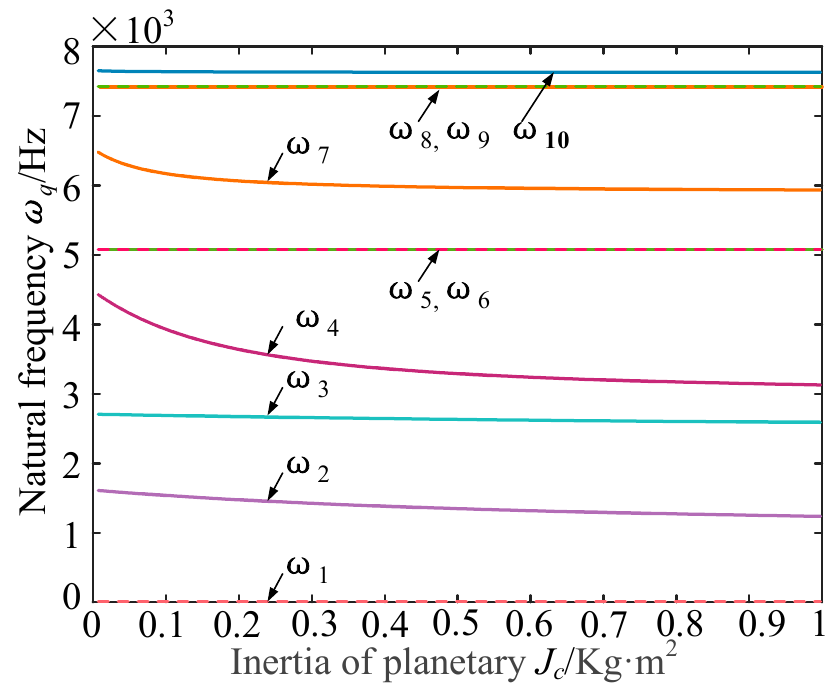
. (cid:3045)(cid:2869)